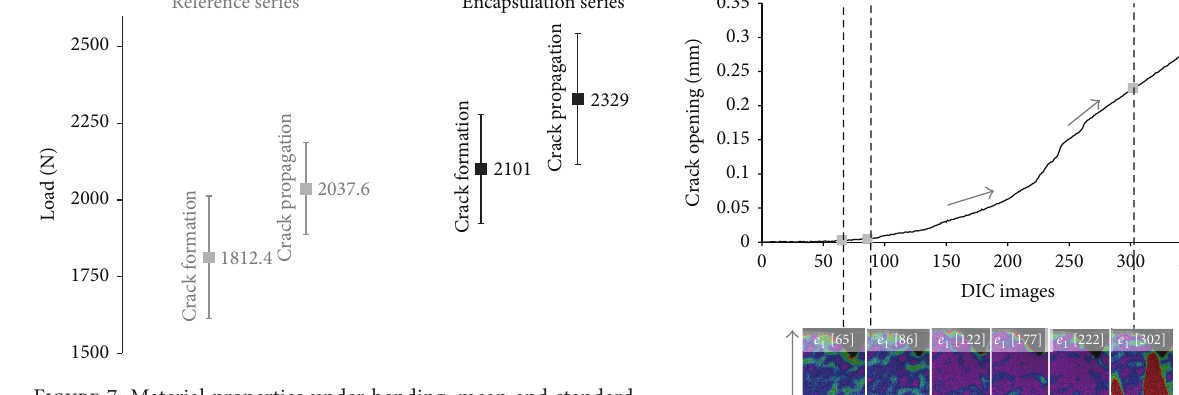
Figure 7: Material properties under bending: mean and standard deviation distribution for the sum of the beams.